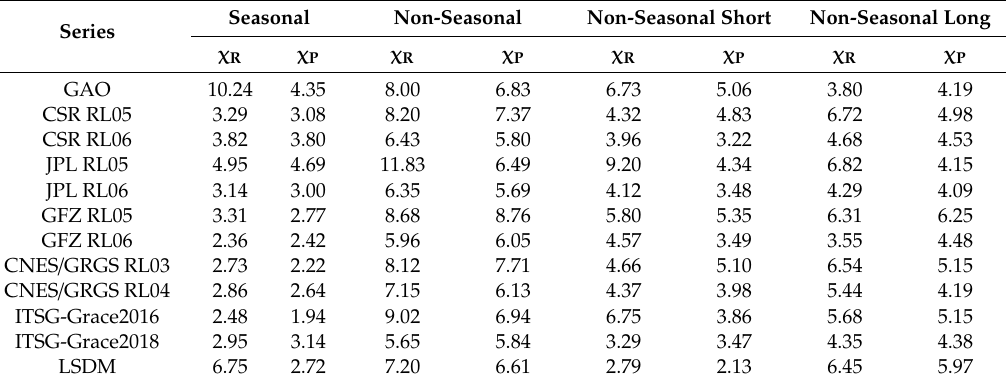
Table A1. Standard deviation of GAO and HAM time series for seasonal, non-seasonal, short-term ( < 730 days) non-seasonal, and long-term ( > 730 days) non-seasonal variation.